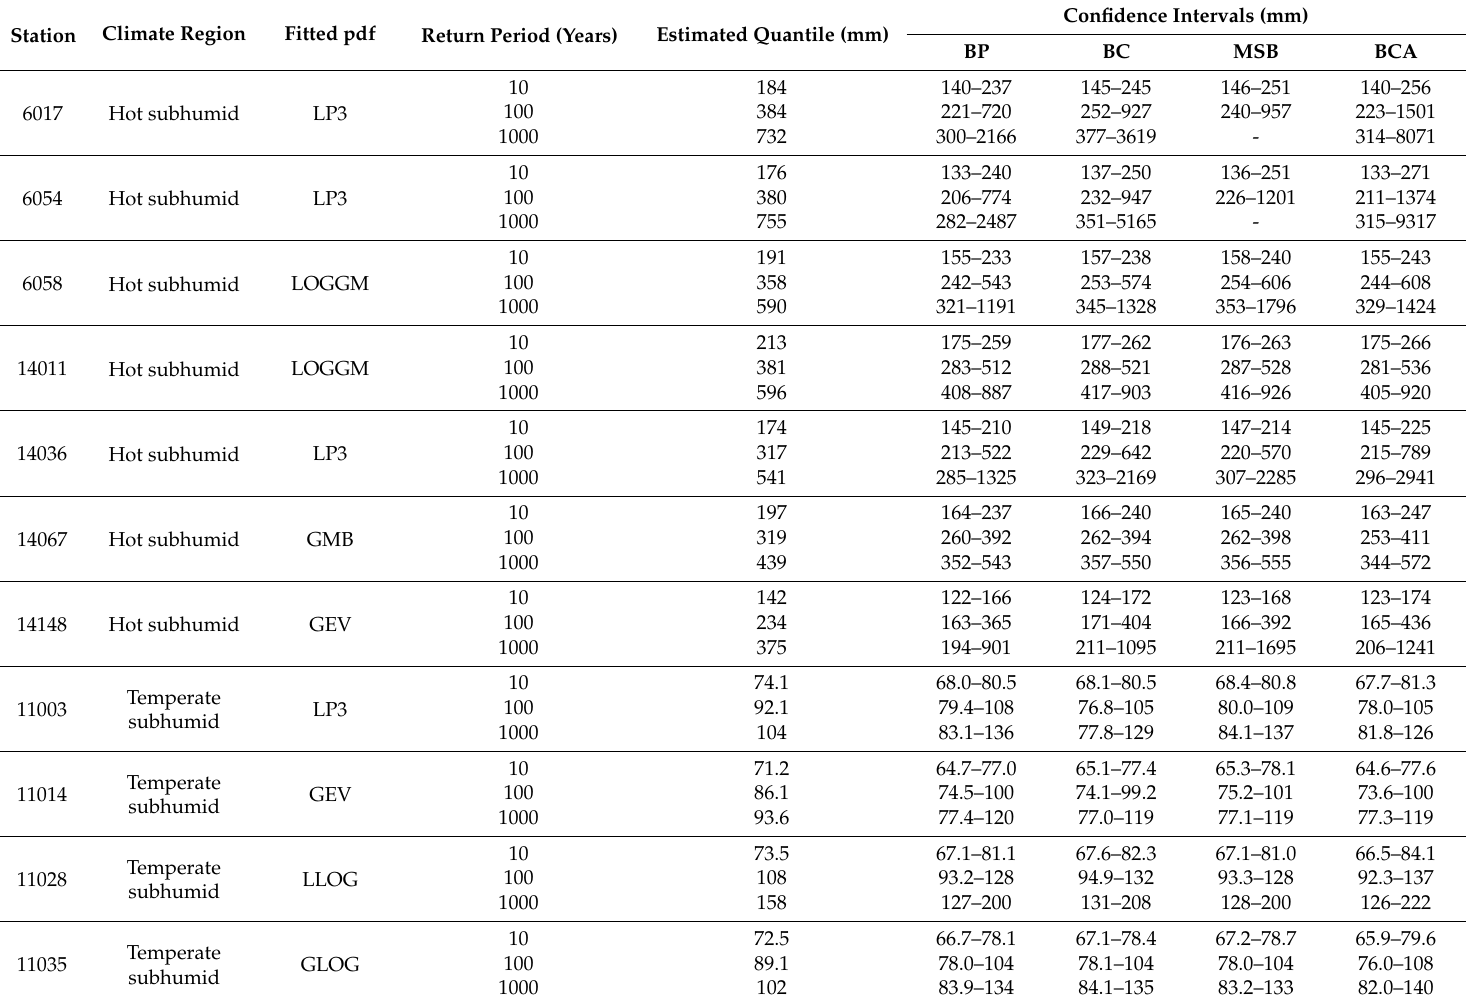
Table 3. Confidence intervals for the quantiles corresponding to the return periods of 10, 100, and 1000